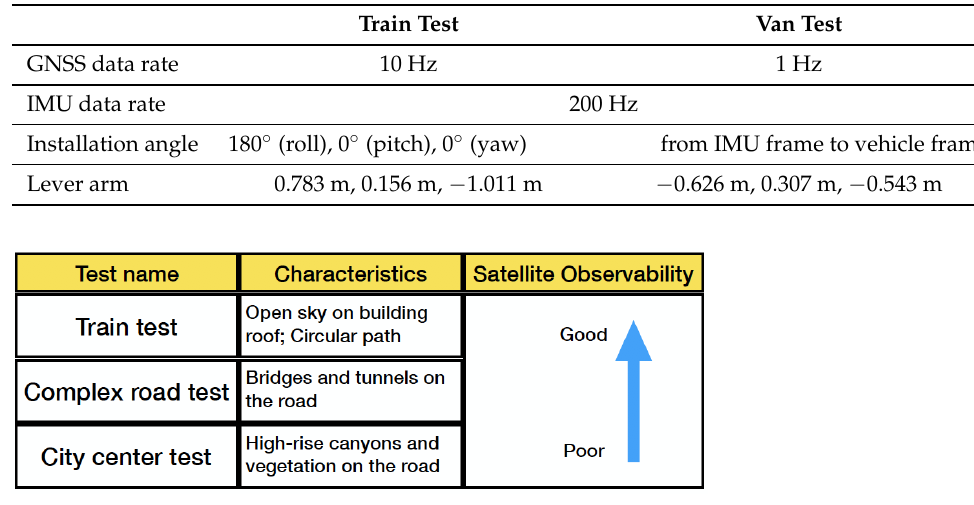
Figure 4. Principle of experimental design.